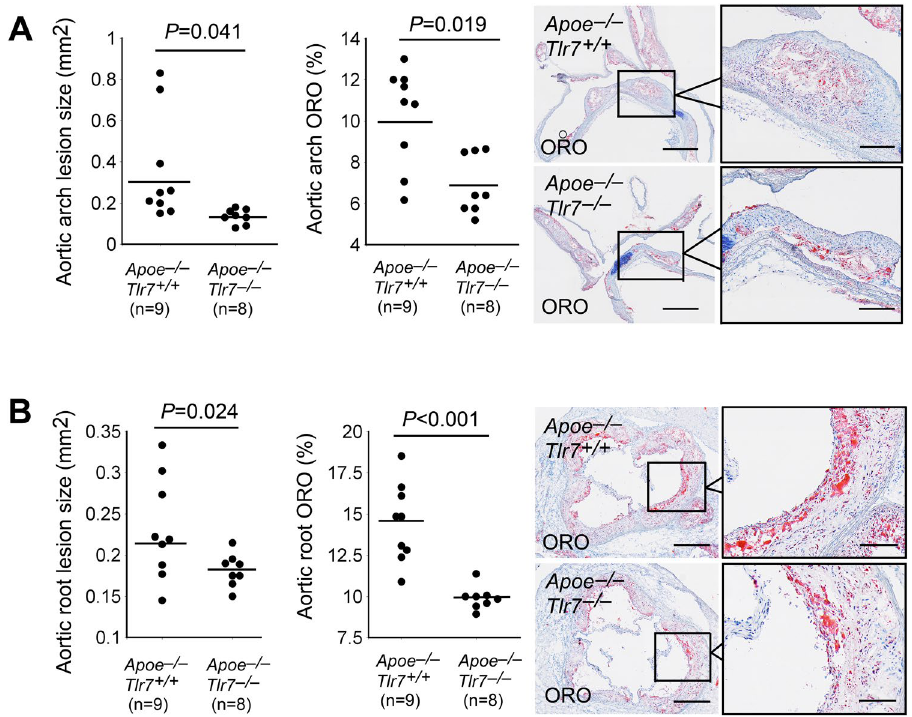
Figure 2. TLR7 deficiency reduces atherosclerotic lesion size and lesion lipid deposition in male Apoe − / − mice after 3 months of an atherogenic diet. ( A) Aortic arch lesion size (left), ORO staining detected lipid deposition (middle), and aortic arch ORO staining representative images. Scale: 1 mm, inset scale: 200 µ m. ( B ) Aortic root lesion size (left), ORO staining detected lipid deposition (middle), and aortic root ORO staining representative images. Scale: 1 mm, inset scale: 200 µ m. Numbers (in parentheses) and genotypes of mice are